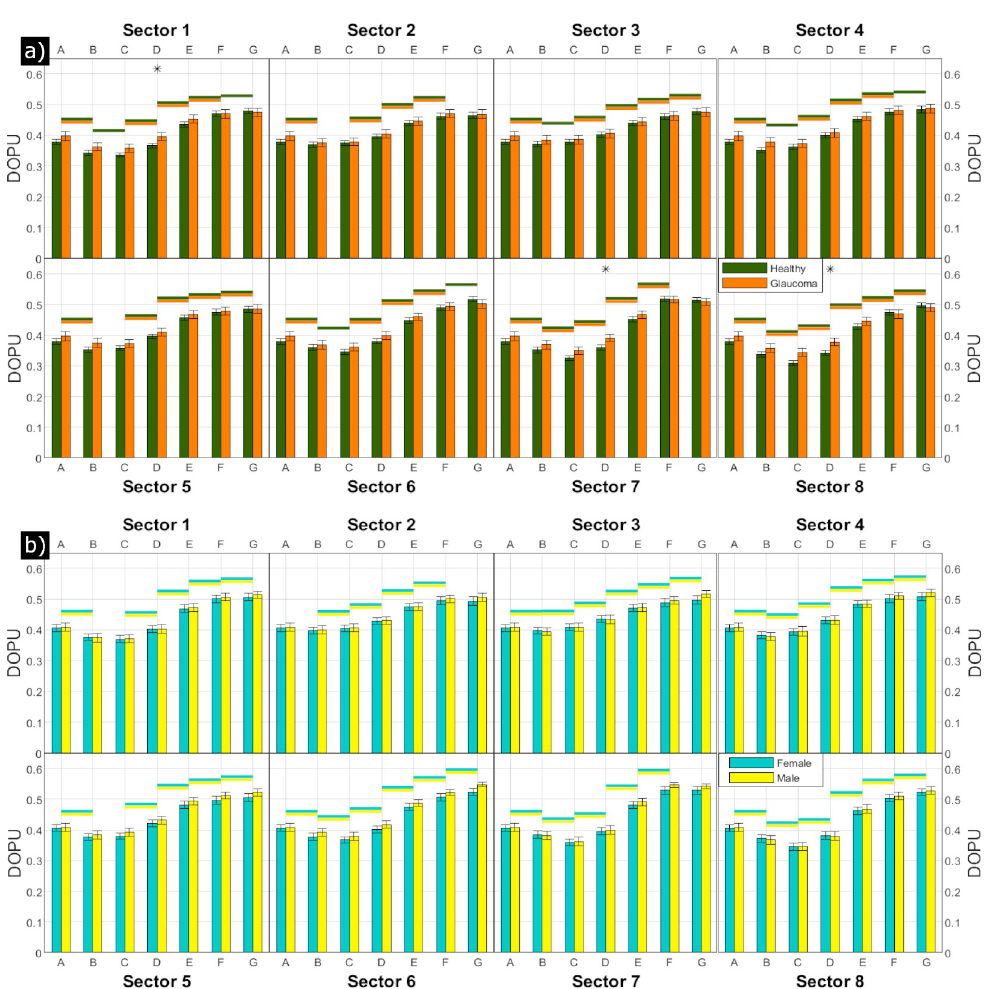
Fig 3. Quantitative analysis of DOPU values for different retinal locations. Each column represents averaged DOPU values for every ring per sector of the grid defined in Fig 2. A denotes the circle at the center, G the outermost ring. The error bars correspond to the standard error across subjects. The color-coded horizontal lines above two neighboring bars indicate that the differences between these fields are significant at 5%. (a) Average over 76 healthy volunteers (green) and over 48 glaucoma patients (orange). All subjects were 39 years old or older. An asterisk above a group of bars indicates that the difference between healthy volunteers and glaucoma patients in this field is significant at 5%. (b) Average over 58 female healthy volunteers (turquoise) and 47 male healthy volunteers (yellow). In no field location the difference between female and male was significant at